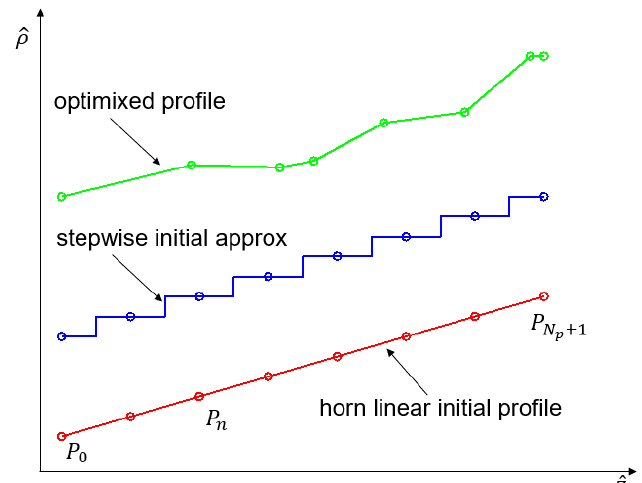
Figure 3. Linear profile for the smooth horn design with the definition of the nodes, initial stepwise approximation and final optimized horn profile. Even if the three curves have the same starting and ending points, they are not plotted one over the other for clearness.